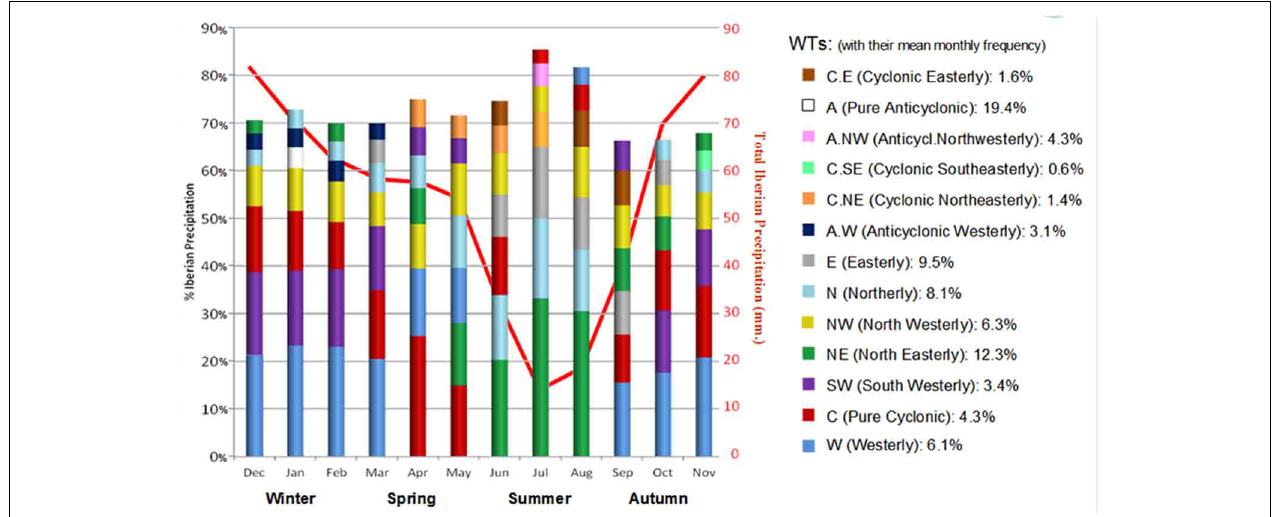
FIGURE 3 | Percentage Contribution of the seven “wettest” WTs to total monthly Iberian precipitation (1950–2003). Highest WT contributors are placed at bottom and the lowest at the top. At monthly level, the type